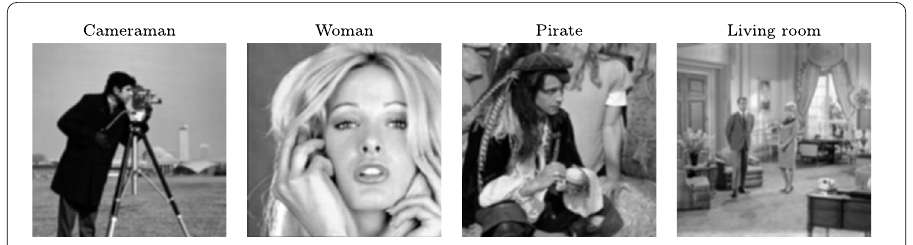
Figure 2 Observed blurred and noisy images